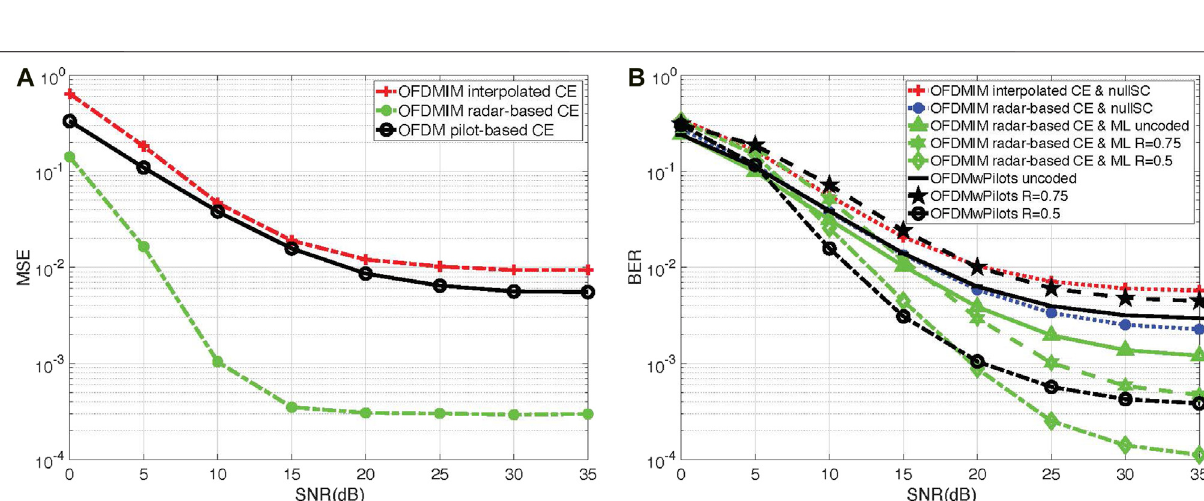
Frontiers in Communications and Networks |